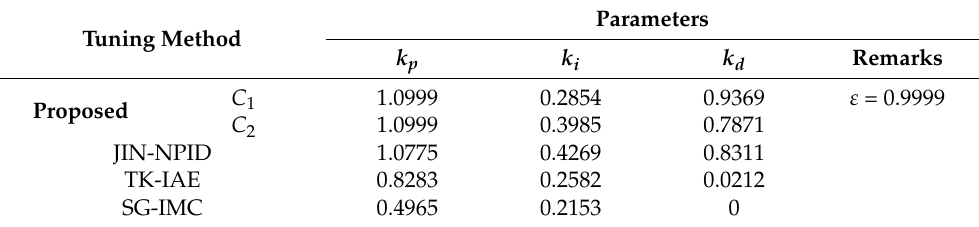
Table 4. PID controller tuning for process